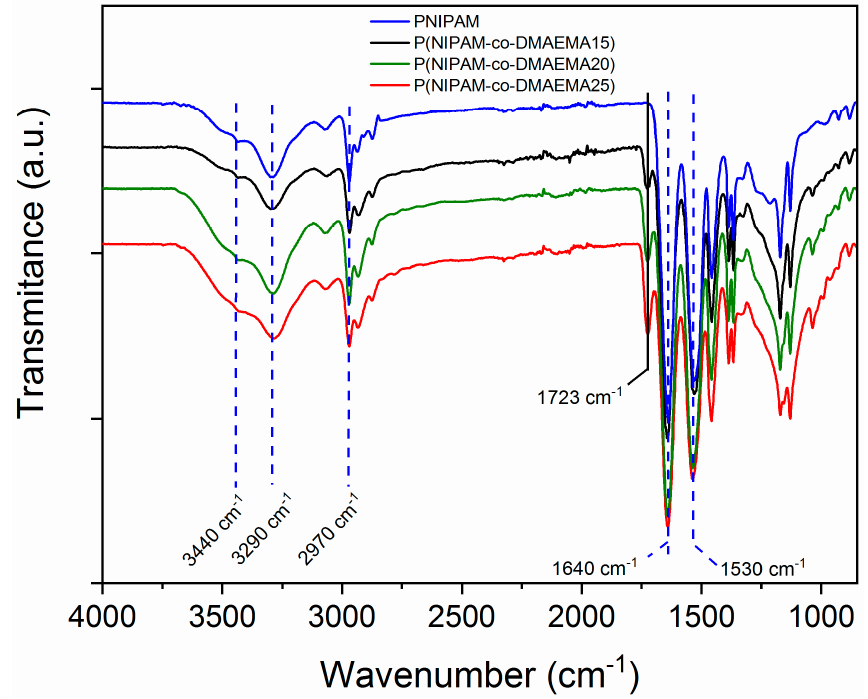
Figure 1. FTIR / attenuated total reflection (ATR) spectra of the poly( N -isopropylacrylamide- co - dimethylaminoethyl methacrylate), P(NIPAM- co -DMAEMA) microgels.